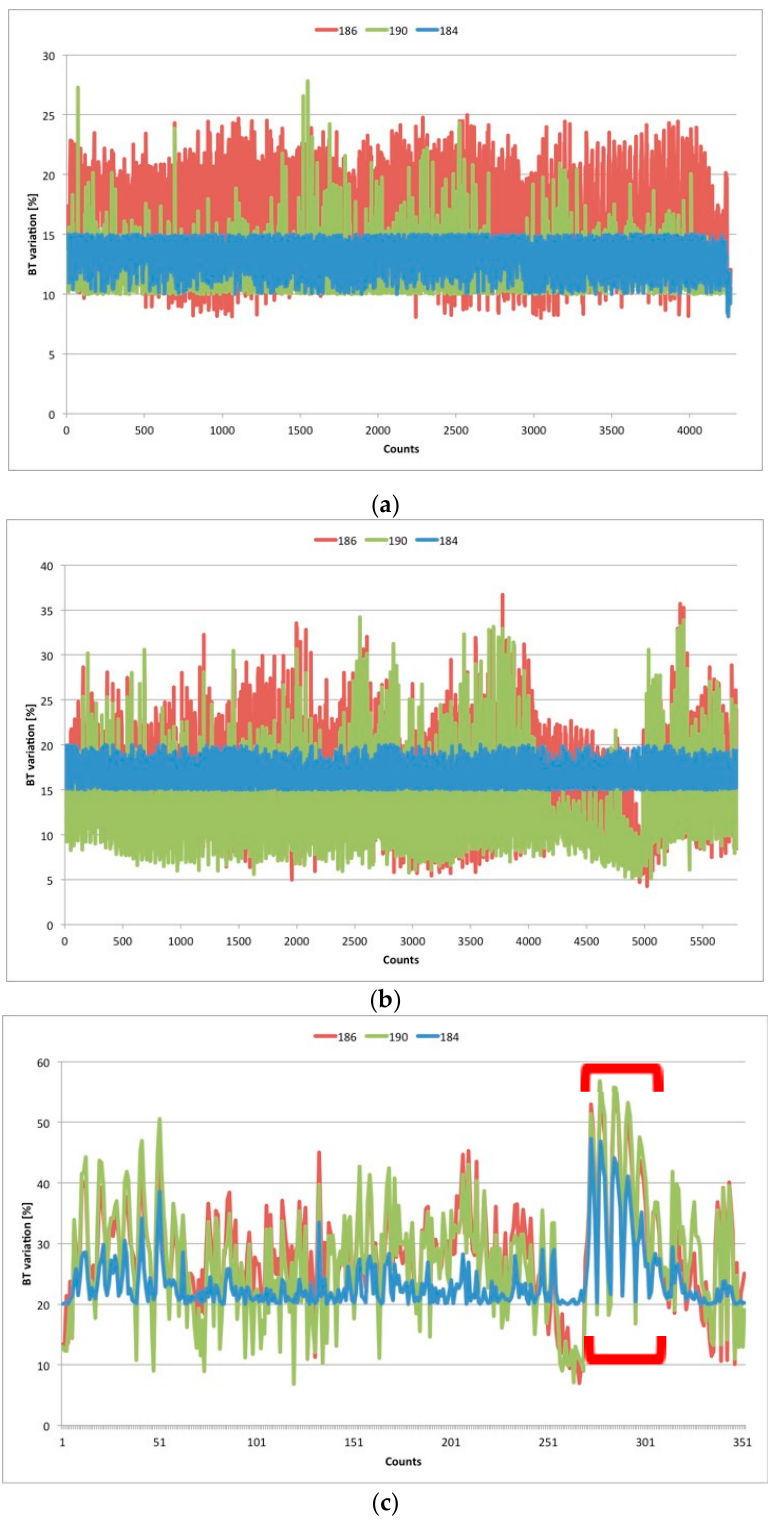
Figure 4. Distribution of the brightness temperature variations TB var as a function of MWCC convective cloud classification (CO) during the hailstorm over South Dakota, 23 July 2010 2254 UTC. ( a ) CO1, ( b ) CO2, and ( c ) CO3. Red brackets enclose the hail signatures inducing strong TB variations in the three water vapor channels.